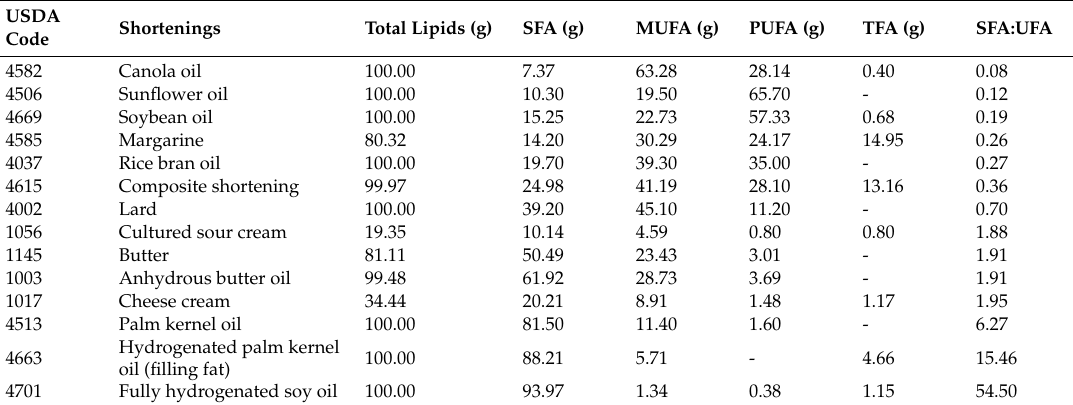
Table 1. Composition of shortening lipids.